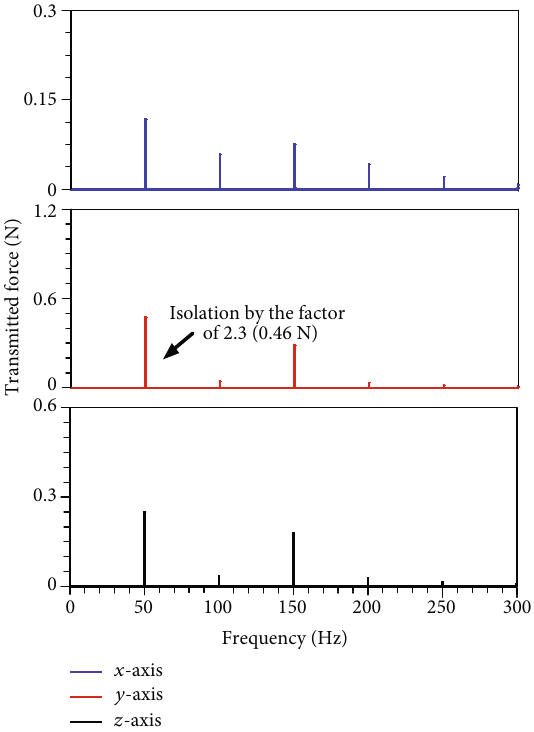
Figure 14: Microvibration measurement test results under 1 g